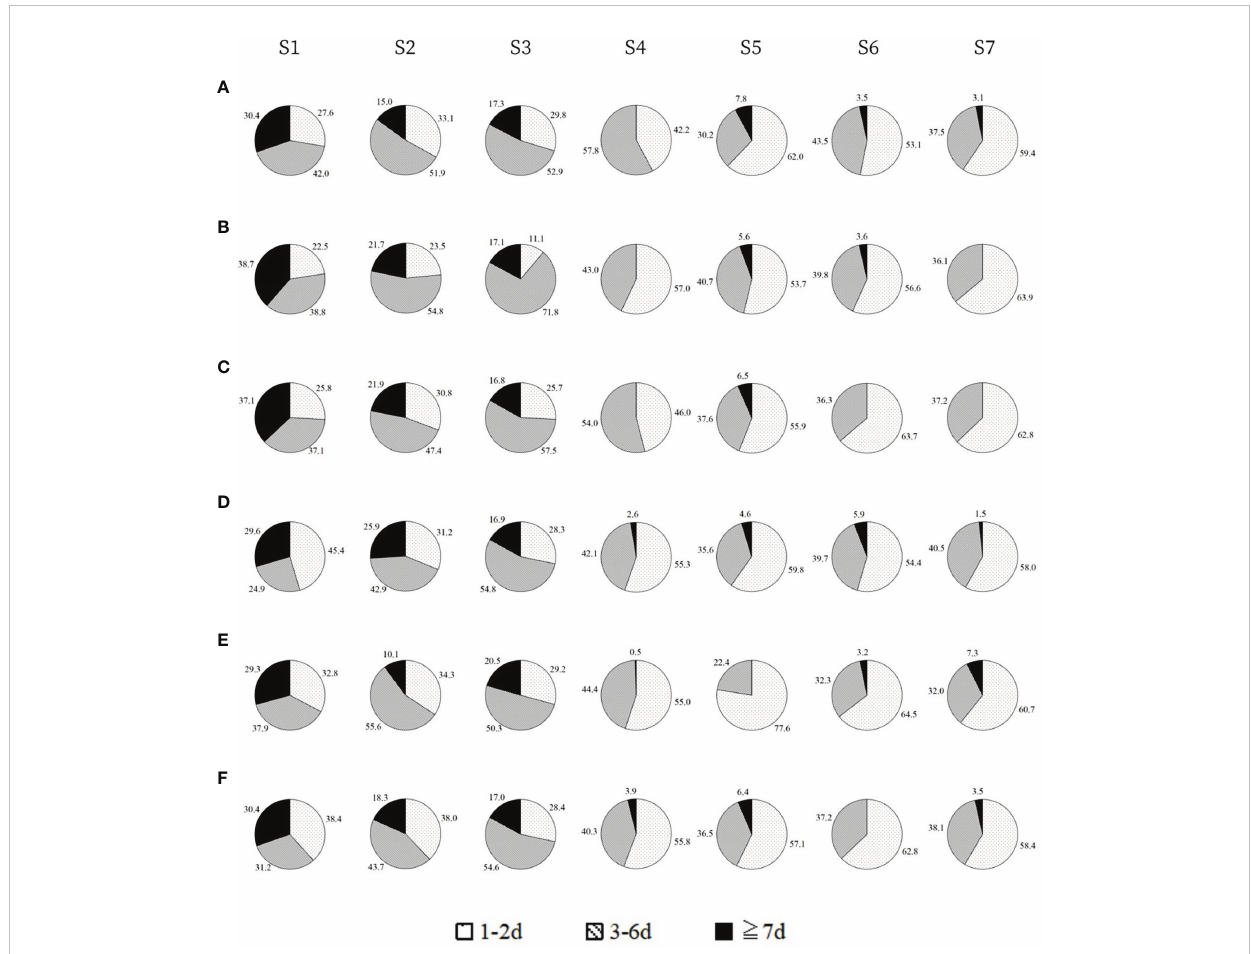
FIGURE 7 Precipitation amount percentages of continuous rain during different wheat growth stages in Yanhuai region i.e. (A) Yingshang, (B) Huoqiu, (C) Fengtai, (D) Shouxian, (E) Huaiyuan, and (F) Fengyang from 1999 to